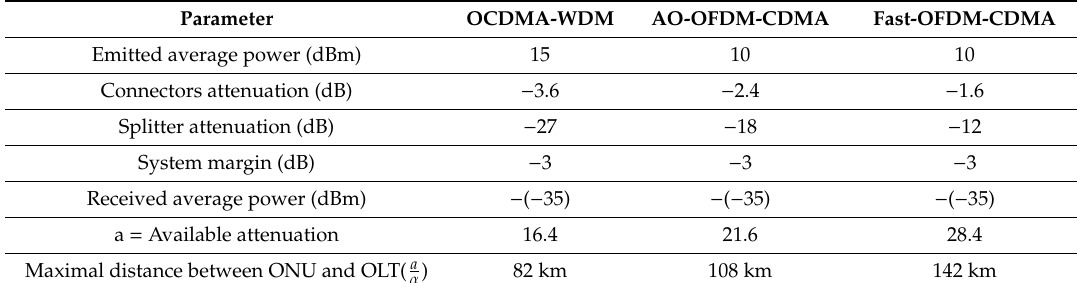
Table 4. Budget power